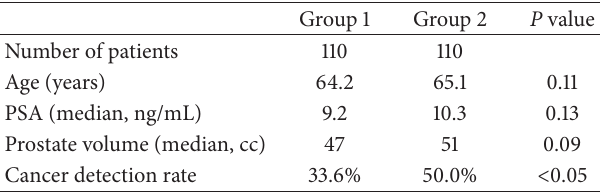
Figure 1: Modified Gore protocol consisting of 2 biopsies of each base, mid, and apex along with routine biopsy of the transitional zone. Table 1: Patient characteristics and cancer detection rate.